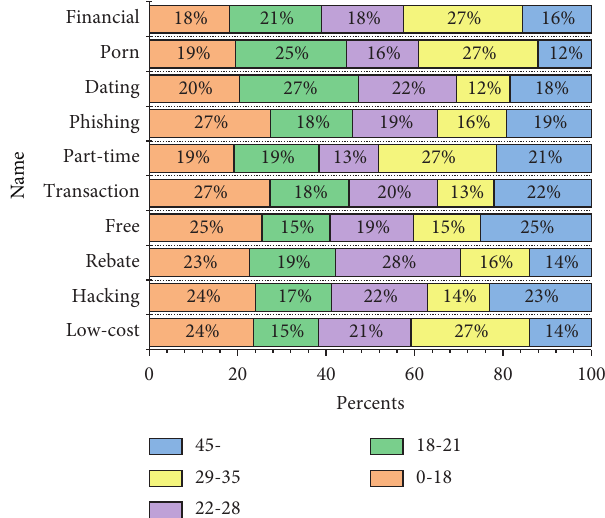
Figure 4: Distribution of age groups of victims of different fraud types in the last four years in County